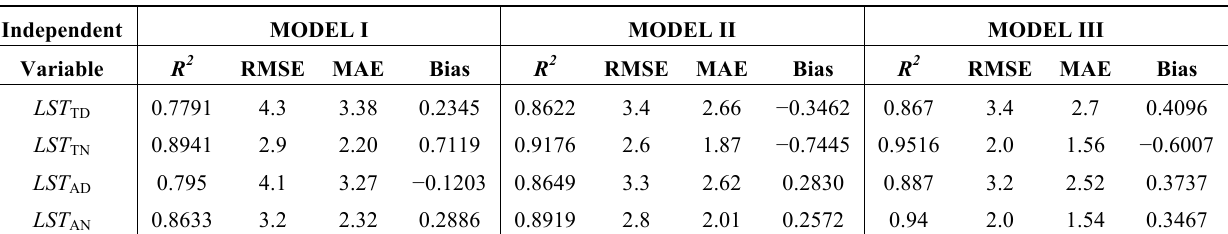
Table 4. Validation of the estimated daily mean air temperature ( TA ) predicted using land surface temperature (LST) data from meteorological stations for the three models in 2012 and 2013.